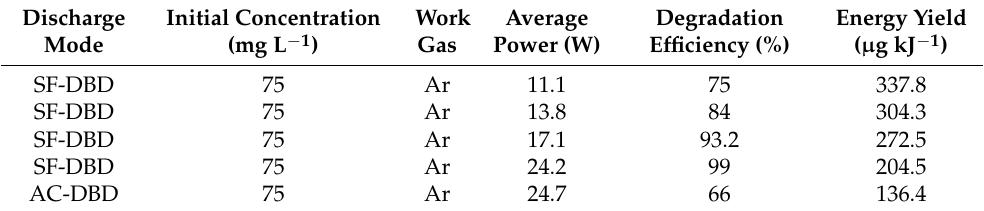
Figure 4. The degradation efficiency of PFOA in ( a ) sinusoidal AC power supply and nanosecond pulse power supply (working gas: Ar; initial concentration: 75 mg L − 1 ) ( b ) different applied power in nanosecond pulse power supply. Table 1. Energy yield under various parameters.